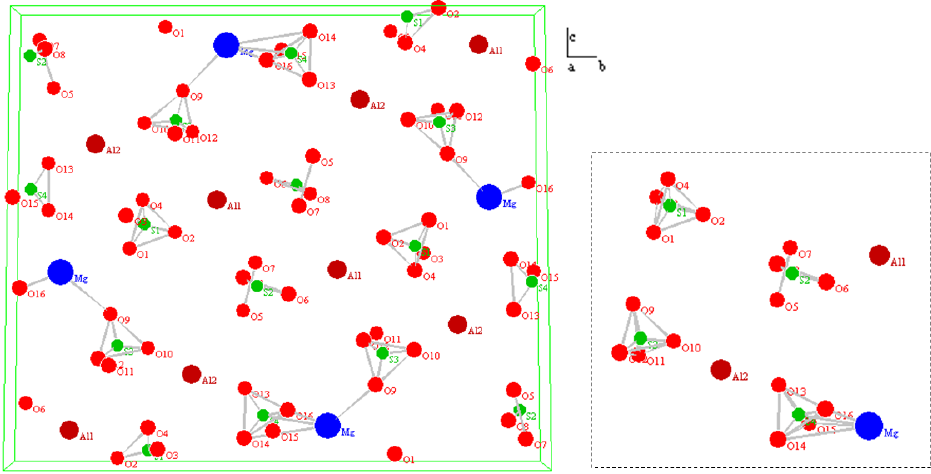
Figure 1. Sketch of the pickeringite structure: MgAl 2 (SO 4 ) 4 ·22H 2 O, obtained with PowderCell program [35]. The water molecules are not represented for simplification: left side-unit cell, right side-asymmetric unit.